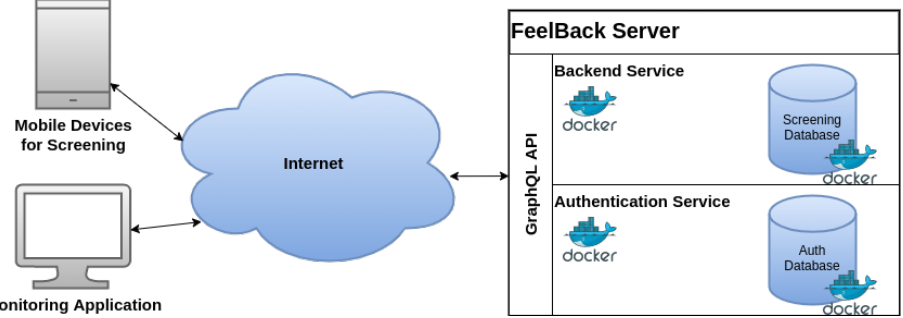
Figure 3. Architecture of the FeelBack-platform. Both, screening devices and monitoring application access the FeelBack server via Internet. The FeelBack-server comprises a dockerized authentication service to secure the server via KeyCloak . The screening data per-se are stored separately and do not contain any personal information of the